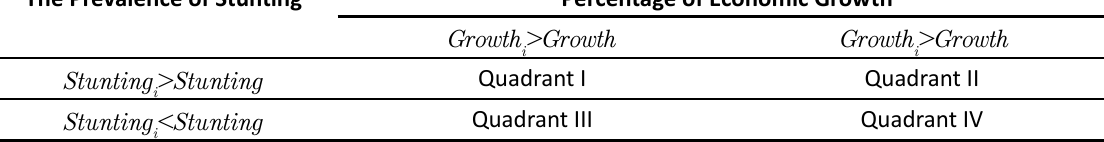
Table 2: Analysis of the Klassen Typology Approach Between Prevalence of Stunting